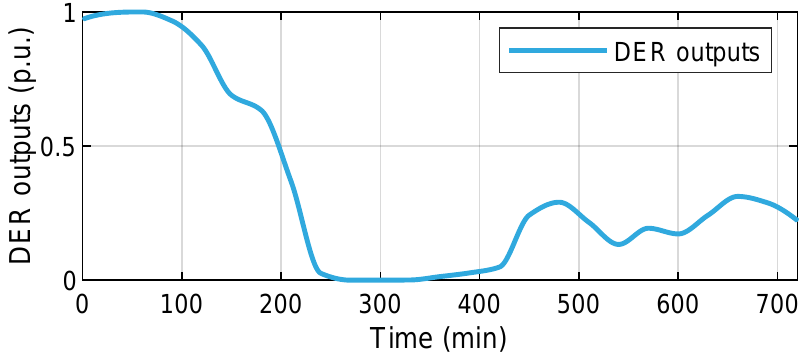
Figure 5. Load curve between 6:00 a.m. and 6:00 p.m.